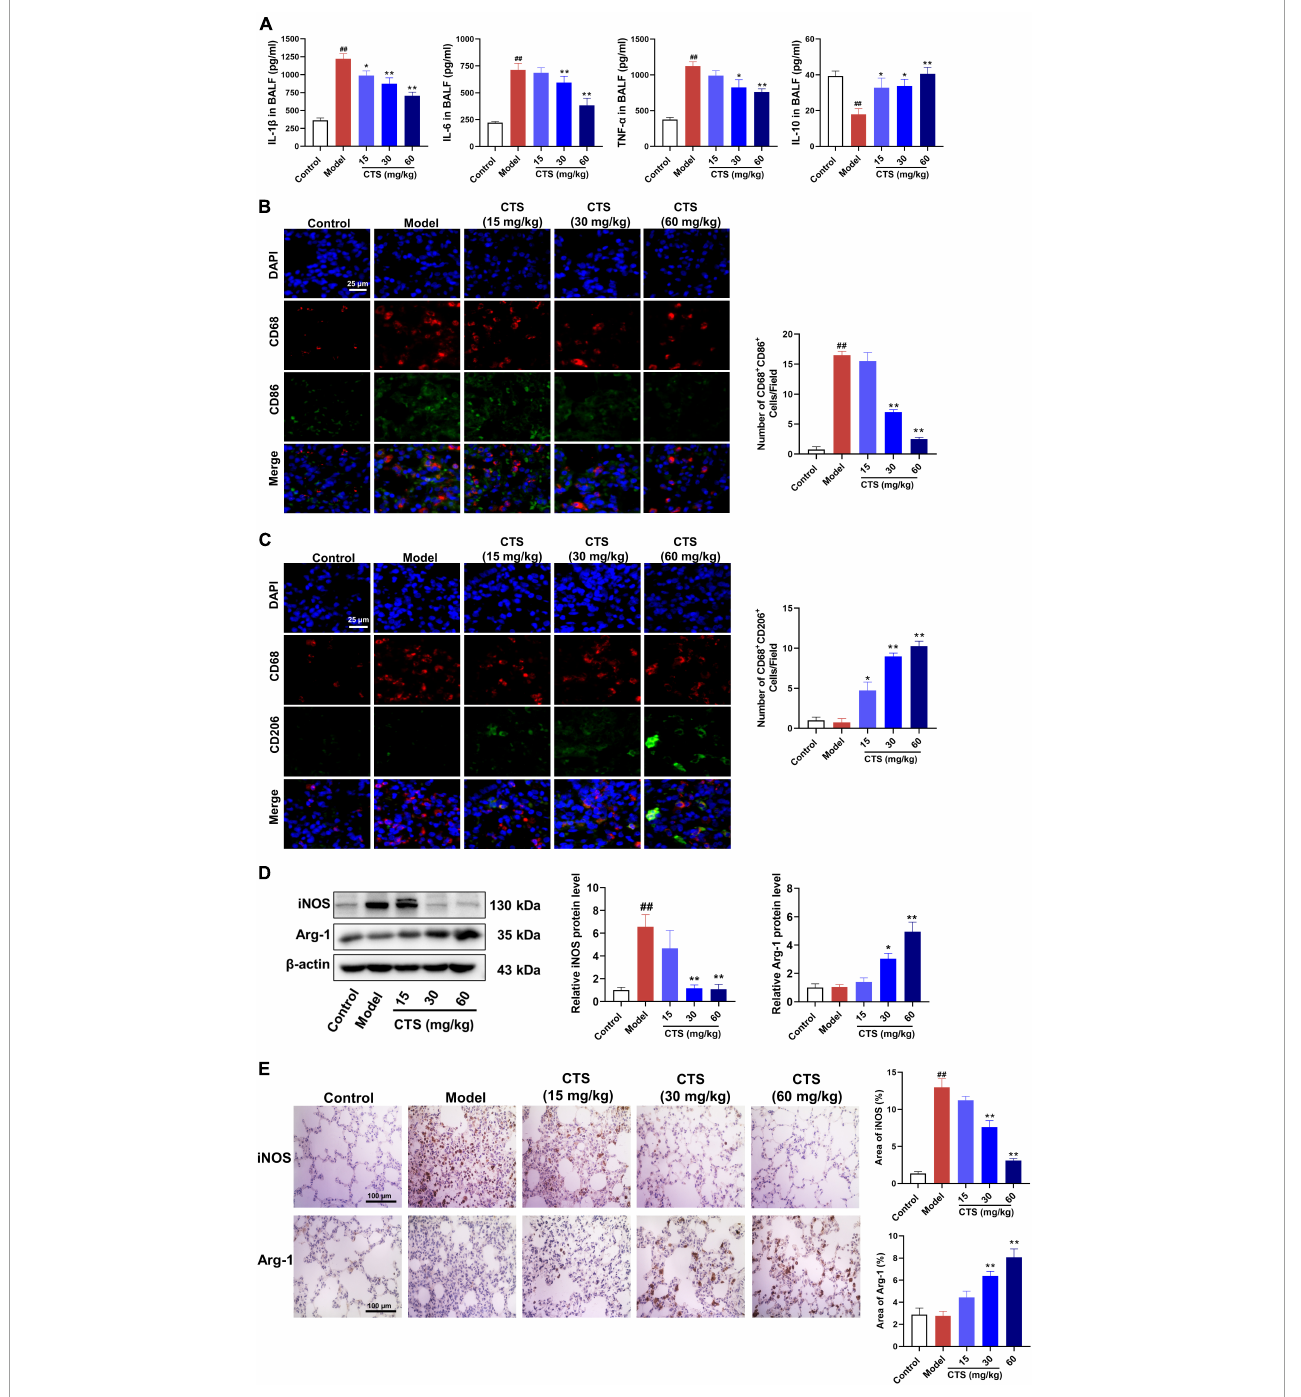
FIGURE2 Cryptotanshinone (CTS) inhibited M1-type polarization and induces M2-type polarization of macrophages in vivo . (A) The levels of IL-1 β , IL-6, TNF- α , and IL-10 in BALF were determined using ELISA, n = 6. (B,C) Representative immunofluorescence image of lung tissues. DAPI (blue), CD68 (red), CD86 (green), and CD206 (green), scales: 25 µ m, n = 4. (D) The protein levels of iNOS and Arg-1, n = 4. (E) Lung sections were immunohistochemically stained by anti-iNOS antibody and anti-Arg-1 antibody, n = 4. Data were presented as the mean ± SEM. ## P < 0.01 vs. the control group; * P < 0.05, ** P < 0.01 vs. the Model